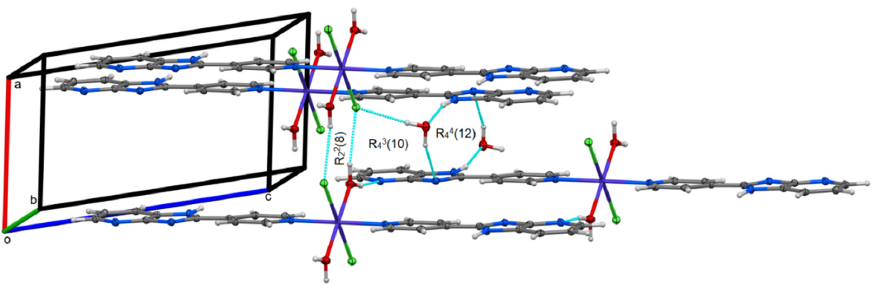
Figure 6. Molecular packing in C1 showing π -stacking interactions: view on a π -stacking layer ( a ); view along a axis ( b ).